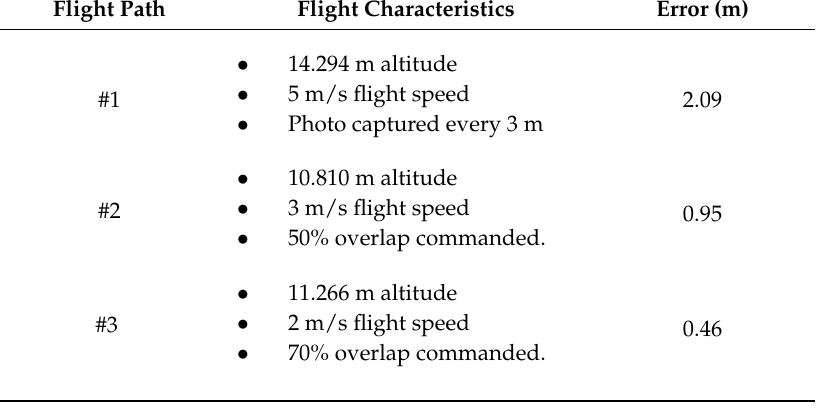
Table 1. Average error (adapted from Chiu et al. [14]).